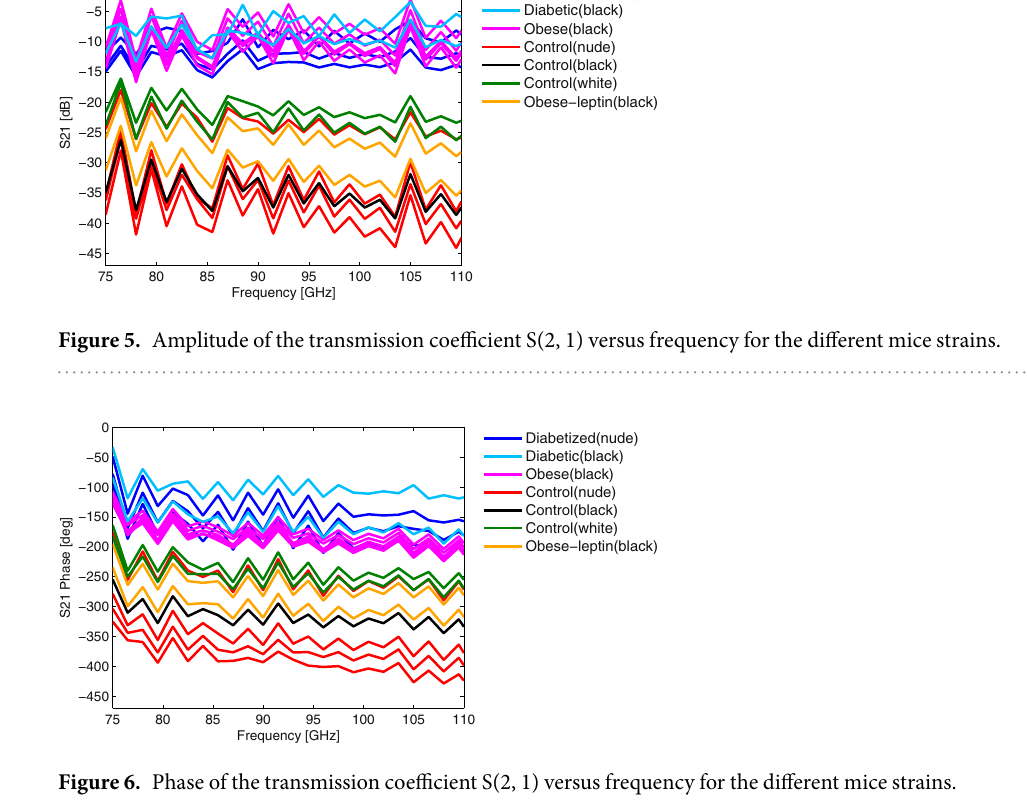
Figure 6. Phase of the transmission coefficient S(2, 1) versus frequency for the different mice